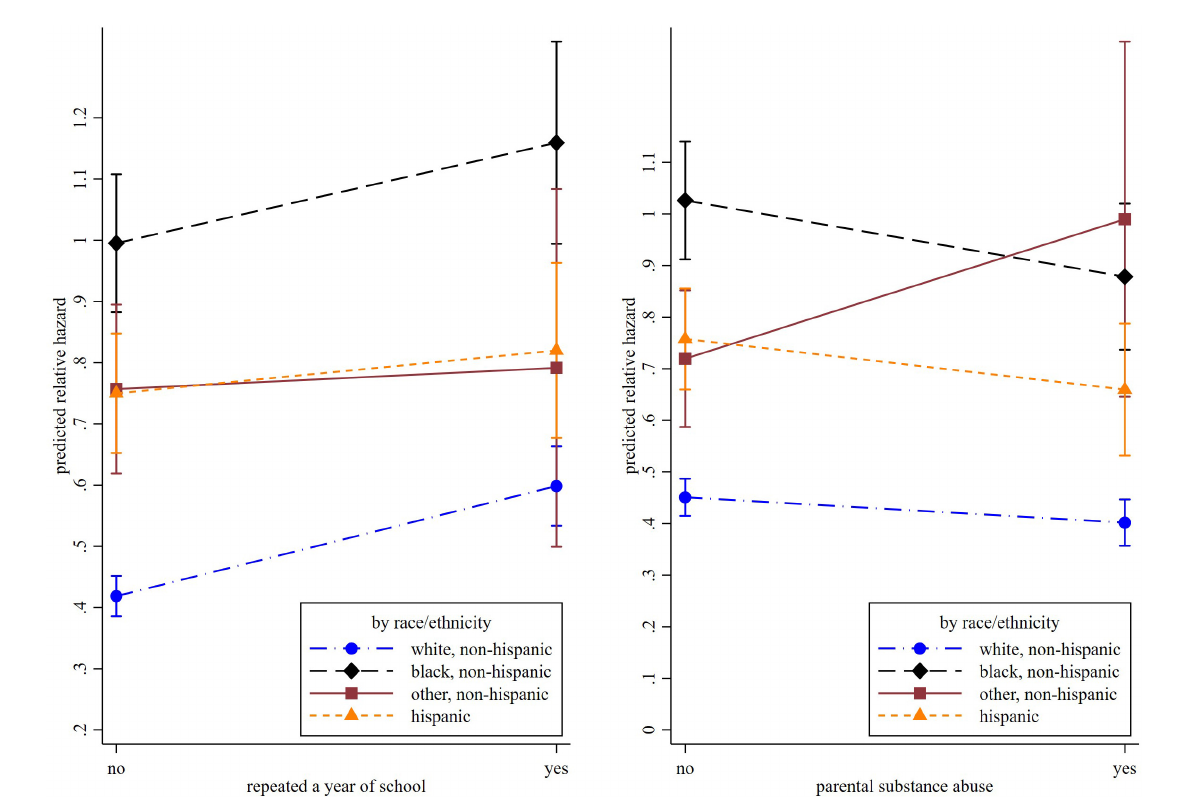
FIGURE3 The predicted relative hazard of cognitive impairment concerning repeating a year of school and parental substance abuse, by